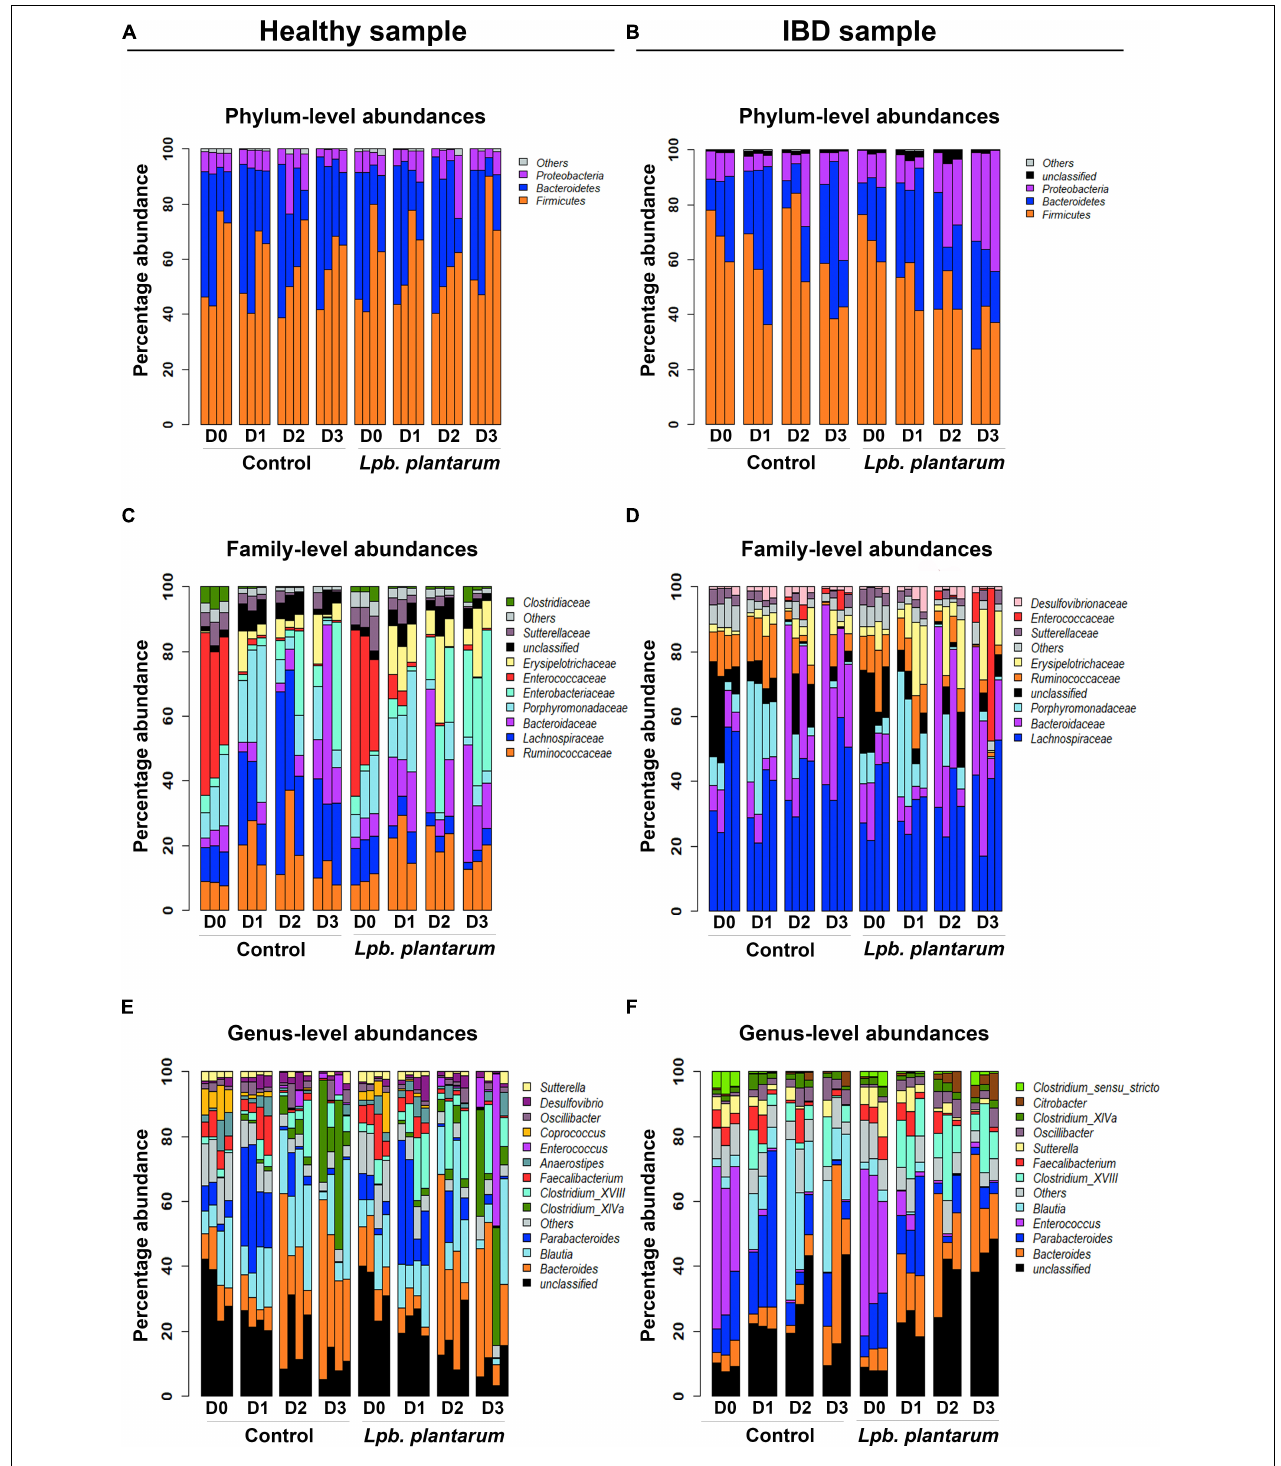
FIGURE 2 | Lpb. plantarum effect on model gut microbial relative abundances of a healthy individual and an IBD patient. Relative abundances are presented at phylum (A,B) , family (C,D) and genus (E,F) levels, with and without treatment of the Lpb. plantarum inoculum. The “Others” category is a composite group of all low-abundance taxa with a mean less than 1%. The “Unclassified” category represents all reads with a confidence score less than 80% at a given taxon level based on classification with mothur and the RDP database (see section “Materials and Methods”). For each panel, taxa are ordered bottom to top based on mean percent abundance across